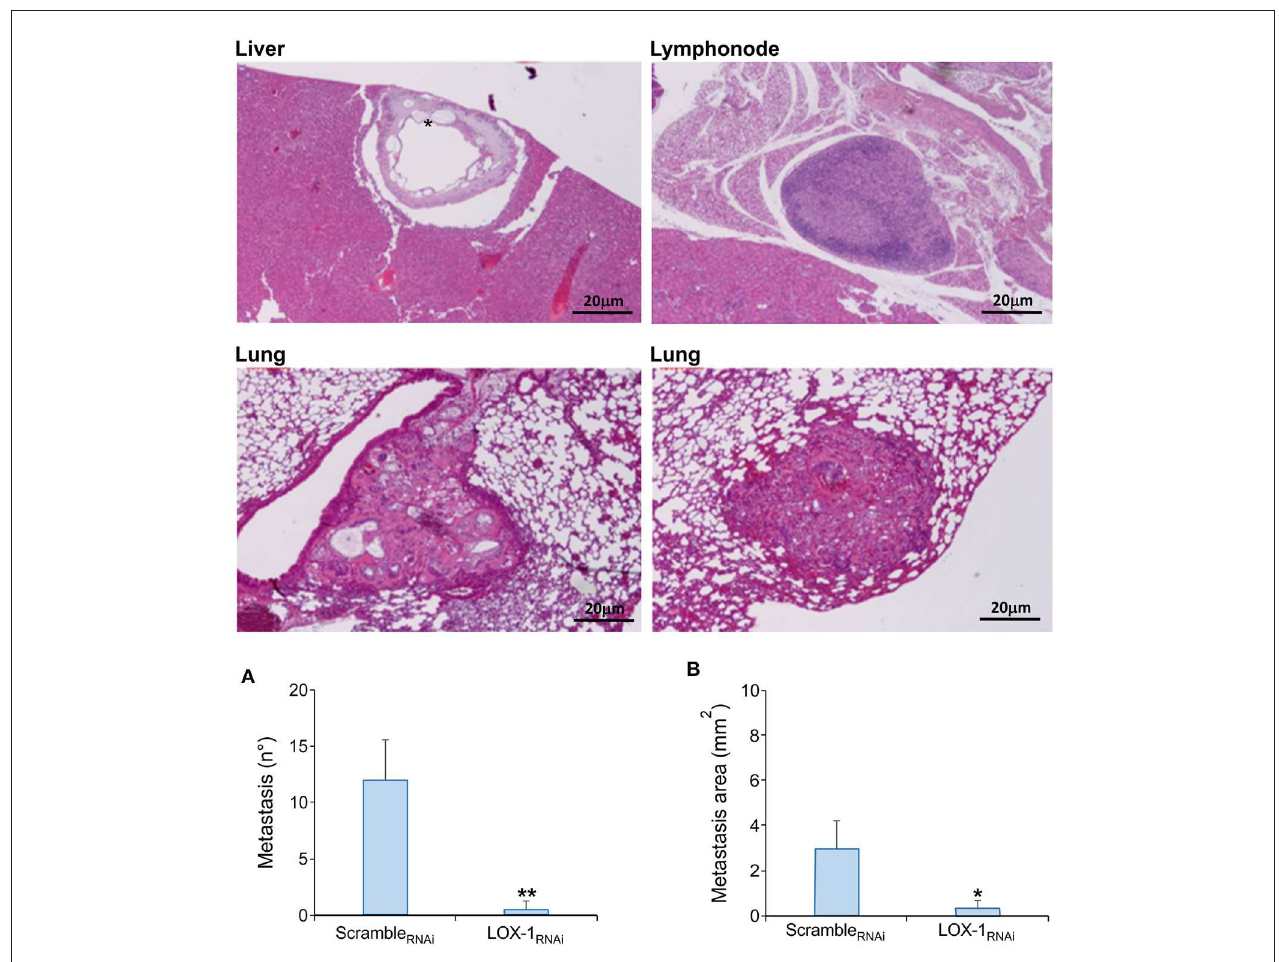
FIGURE 4 | Representative images of murine organs evaluated on H&E sections. Metastasis foci have been evidenced in liver, lung and lymph nodes in mice endovenously injected with scramble RNAi DLD-1 cells. Metastatic repetitions with mucinous aspect were found in all liver of scramble RNAi mice (*). Scale bar 20 µ m. Quantitative analysis of metastasis number (A) and metastatic area (B) in tissues obtained from mice endovenously injected with scramble RNAi and LOX-1 RNAi cells. Metastasis number and area are significantly reduced in LOX-1 RNAi injected mice respect to those injected with scramble RNAi cells. ** P < 0.02,* P <